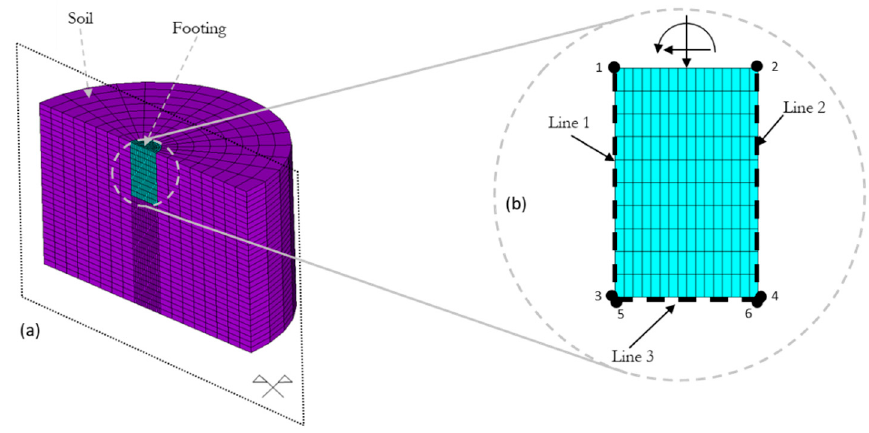
Figure 14. Finite element model for a concrete footing: ( a ) mesh and ( b ) stress lines in the plane of symmetry.